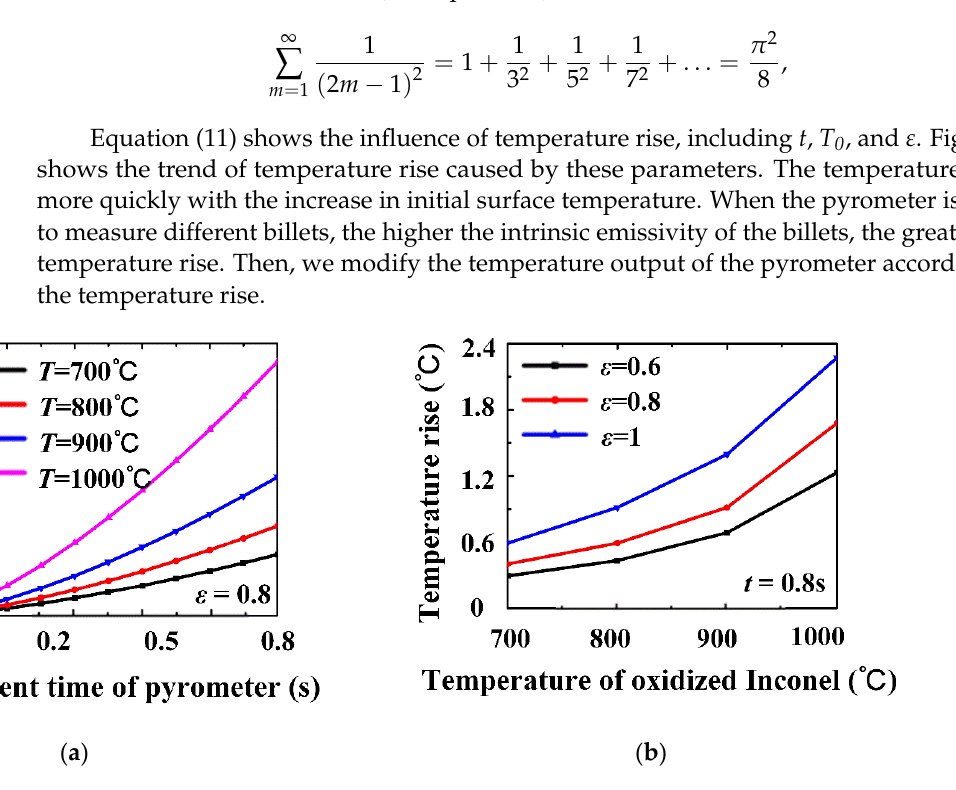
Figure 9. The trend of temperature rise caused by reflector. ( a ) Different temperatures of Inconel 600; ( b ) different intrinsic emissivities of billets. ( b ) different intrinsic emissivities of